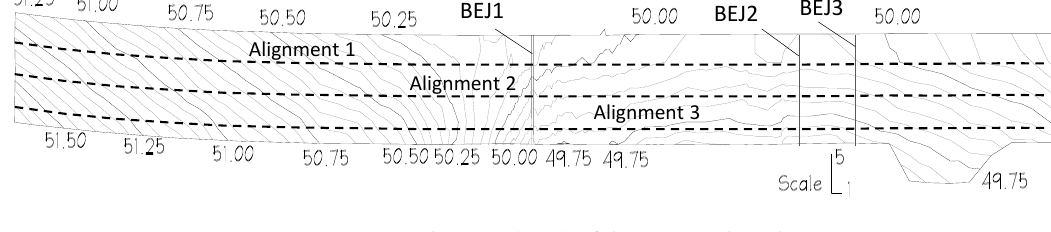
Figure 12. Level curves (in m) of the surveyed road.